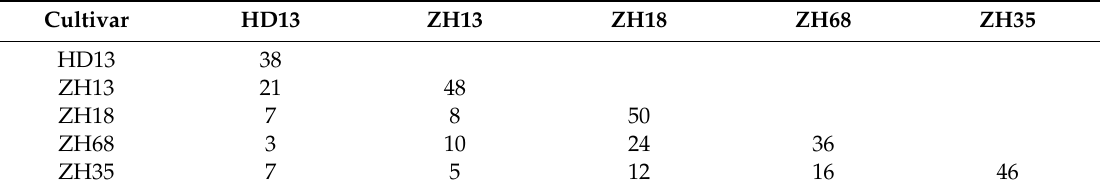
Table 4. The number of same heterozygous loci between two di ff erent soybean cultivars based on